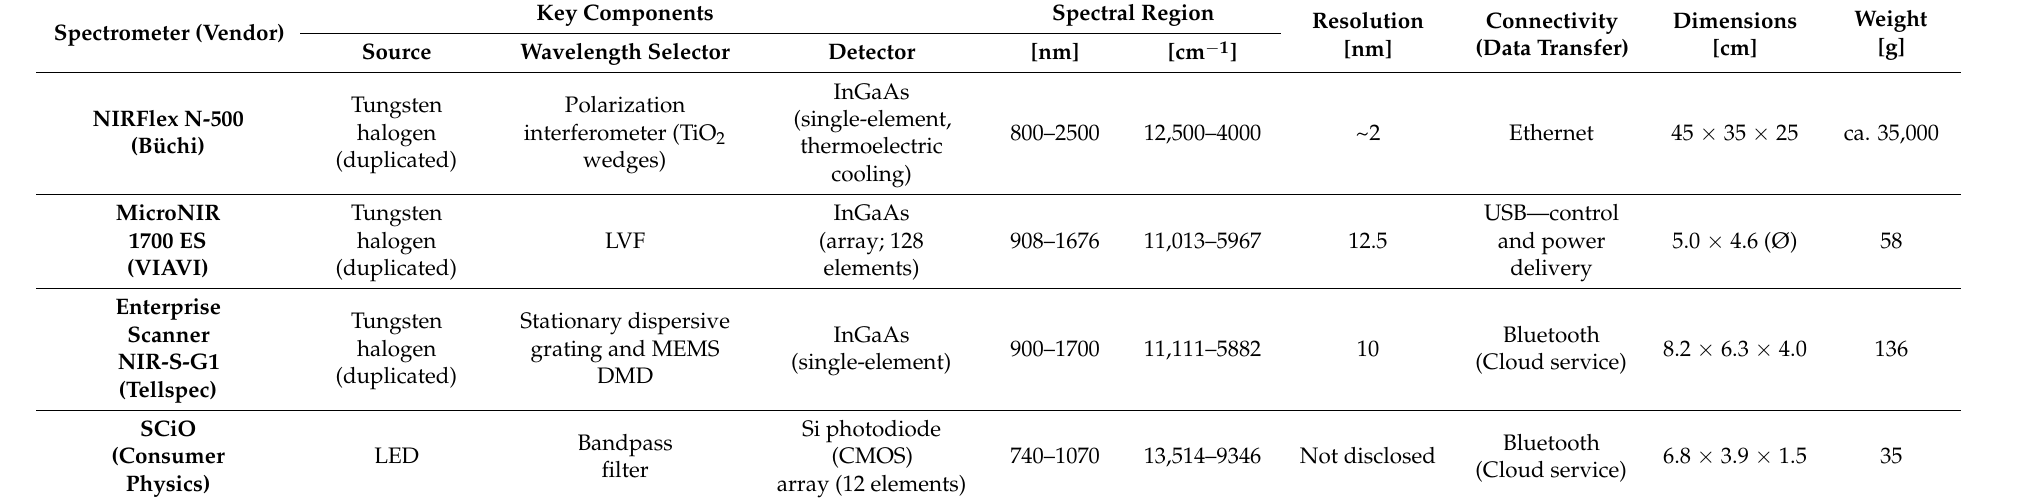
Table 1. Technical parameters of the spectrometers used in this